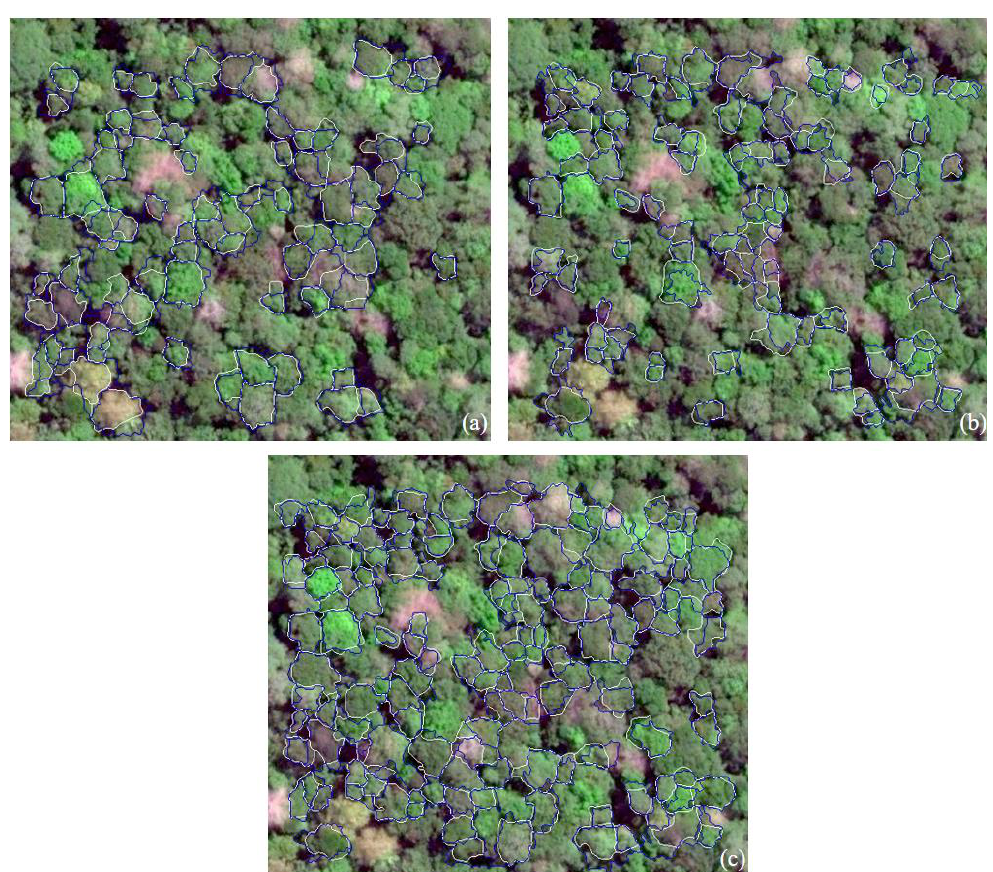
Figure 11. The correctly delineated crowns (in blue) obtained by the Crown Slices from Imagery (CSI) ( a ), the commonly used marker-controlled watershed segmentation (MWT) ( b ), and the proposed (SMS) ( c ) methods, respectively, and the corresponding references (in white) of the rainforest plot.